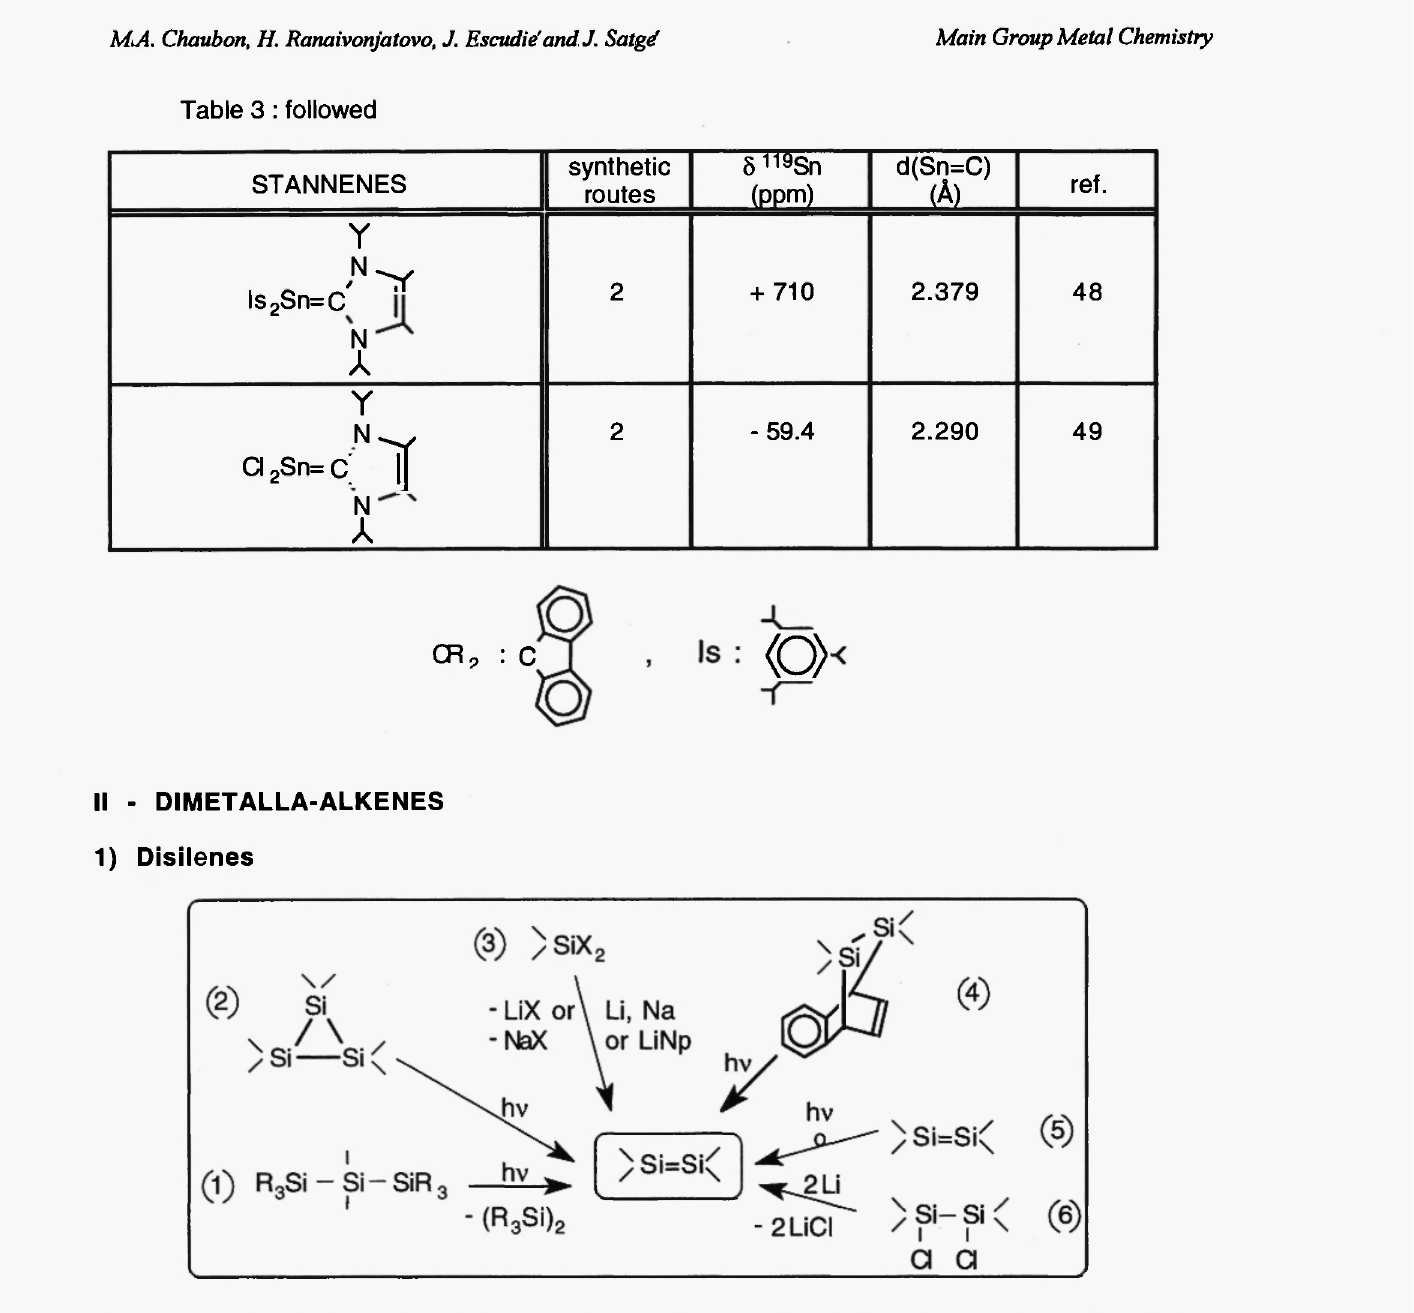
Table 3: followed STANNENES